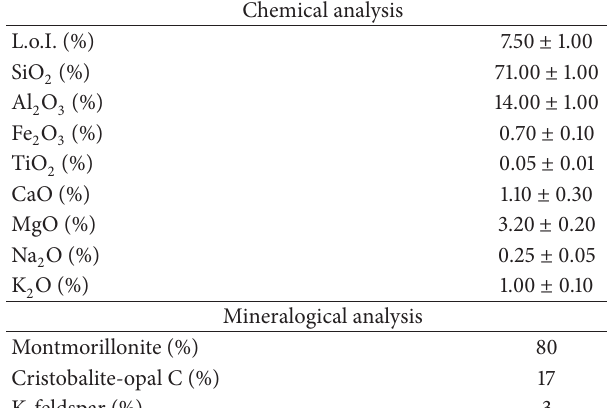
Table 1: Properties of the bentonite.